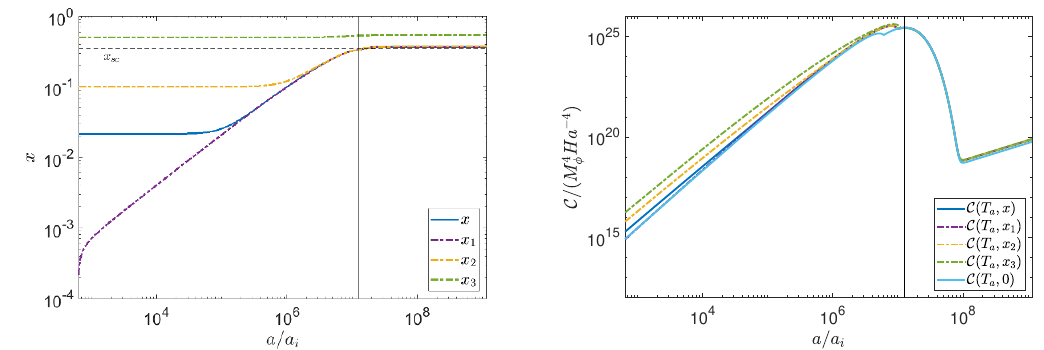
Figure 7. Left panel: evolution of post-reheating temperature ratios for several di(cid:11)erent initial conditions. The solid blue line shows the evolution x = T b =T a from (cid:12)gure 6. The dot-dashed lines ( x 1 ; x 2 and x 3 ) indicate the temperature ratio evolution after arti(cid:12)cially varying the initial condition for T b ( x 1 ;i = 0, x 2 ;i = 0 : 1 and x 3 ;i = 0 : 5). The horizontal black dashed line corresponds to the analytic estimation of the (cid:12)nal temperature ratio derived in eq. (4.15). Right panel: the collision terms (normalized by M 4 Ha (cid:0) 4 ) experienced by the colder sectors plotted on the left panel. The (cid:30) solid light blue line represents the evolution of the collision term when the T b -dependence of C E is neglected. The vertical black line in both panels indicates the scale where T a = M (cid:30) =